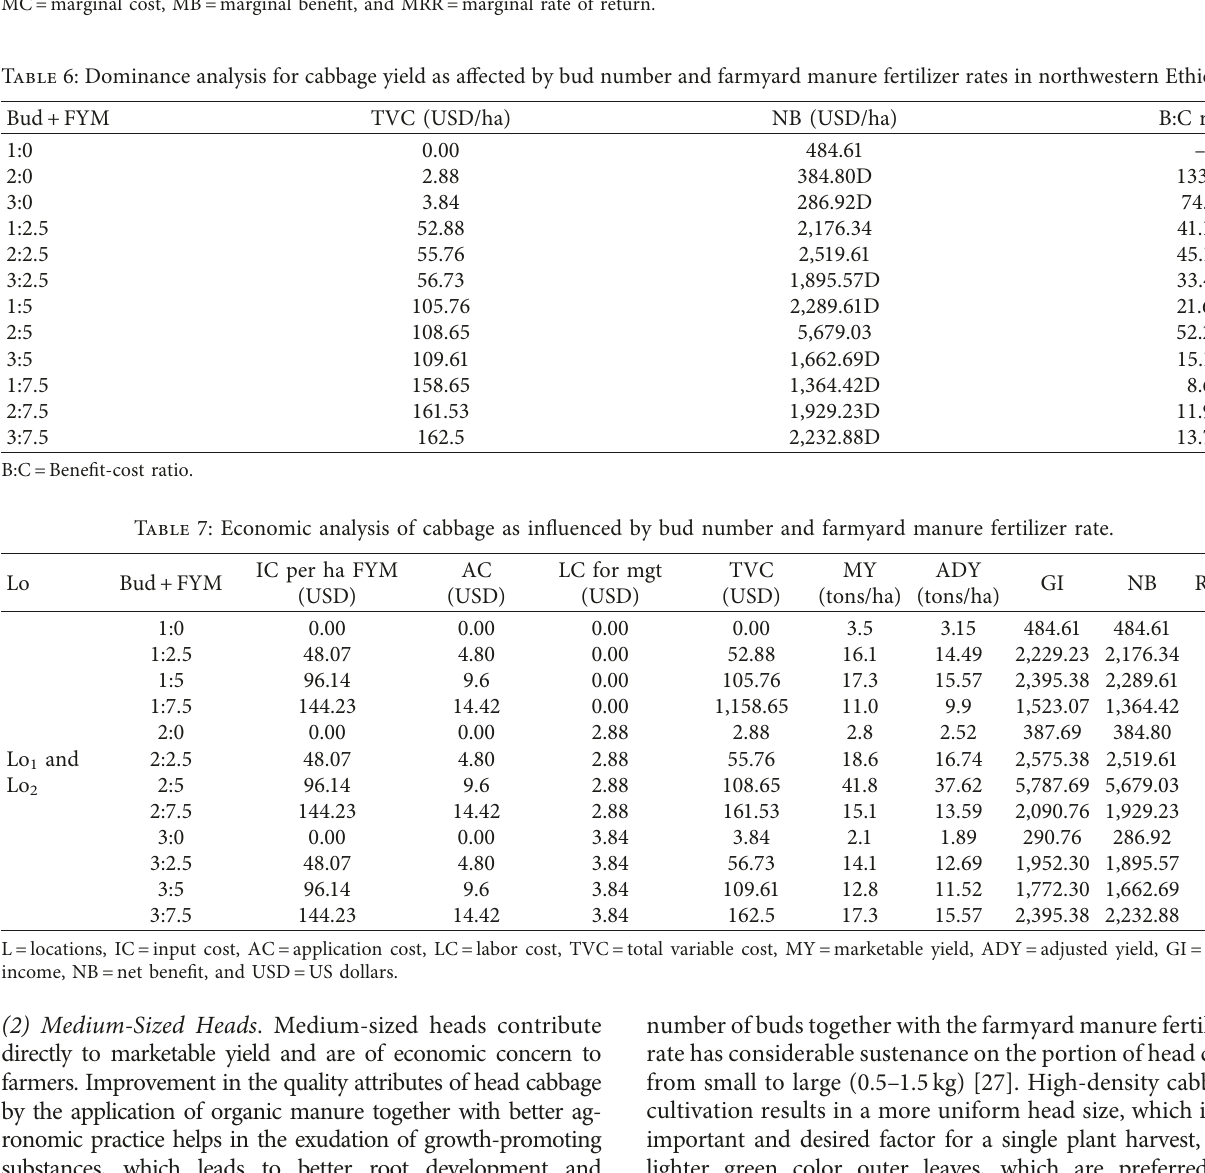
Table 6: Dominance analysis for cabbage yield as affected by bud number and farmyard manure fertilizer rates in northwestern Ethiopia. Bud +FYM TVC (USD/ha) NB (USD/ha)